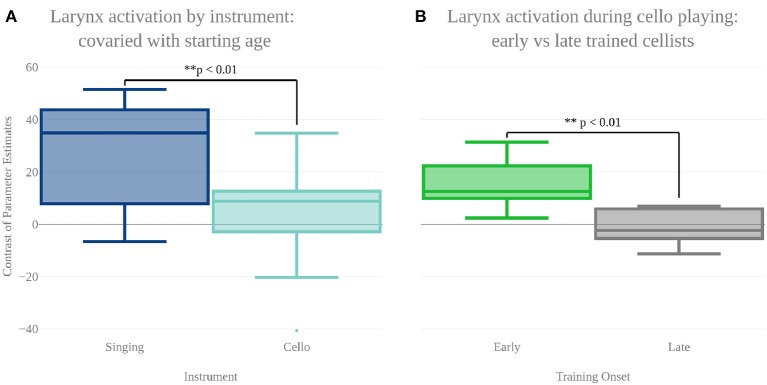
(A) Contrast of parameter estimates (units arbitrary) in larynx area of motor cortex for singing (blue) and cello playing (turquoise). When starting age is included as a covariate, anova shows a significantly more activity in larynx area during singing than cello playing. (B) Mean contrast of parameter estimate values in larynx area of motor cortex during cello playing for Early trained (green) and Late trained (gray) cellists. Cellist that started training before age 7 show significantly more activity in larynx during cello playing than do those that started age 7 and later.